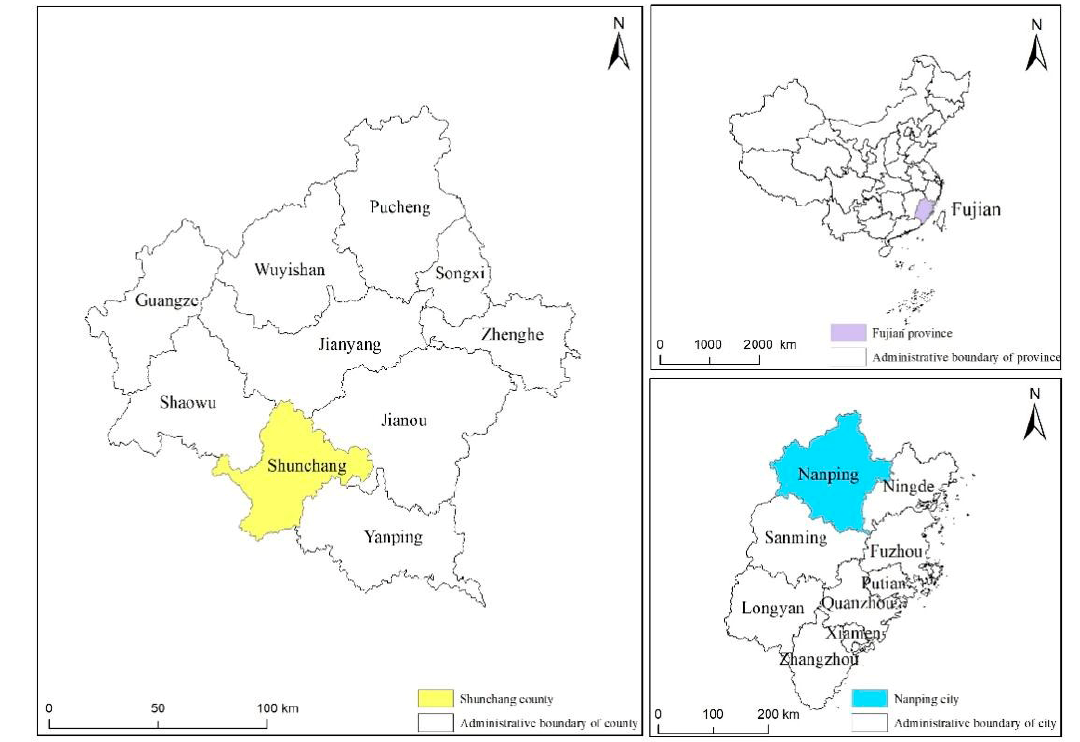
Figure 2. The location of the study areas. Shunchang County is a National Model Green Unit and the forest county and garden city of Fujian Province. It is rich in forest resources, with 80.5% [38] forest cover and a forest stock volume of 15.64 million m 3 [38]. Its area of forestry land in is 166,000 hectares, including 39,300 hectares of state-owned forest farms and 126,700 hectares of collective and individual forest land [87]. Despite 76% of Shunchang County being covered by forest, its forest land is fragmented and diffuse in rural households [88].